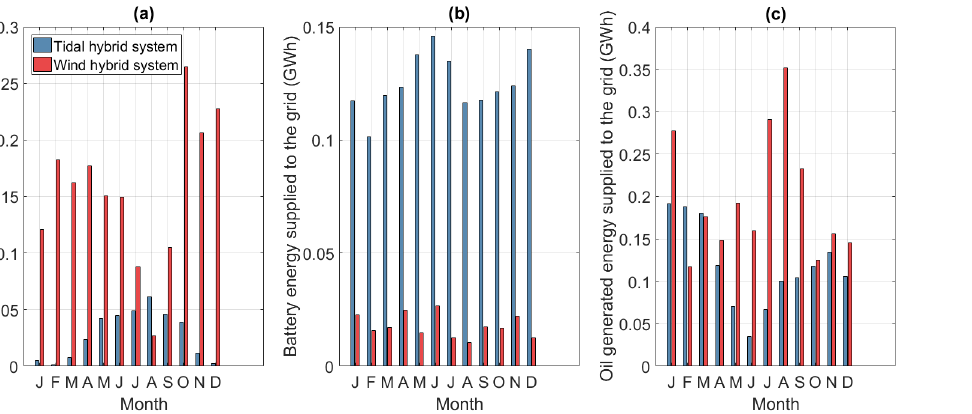
Figure 9. Comparison between THS and WHS ( a ) curtailed turbine power, ( b ) battery energy supplied to the grid and ( c ) oil generated energy supplied to the